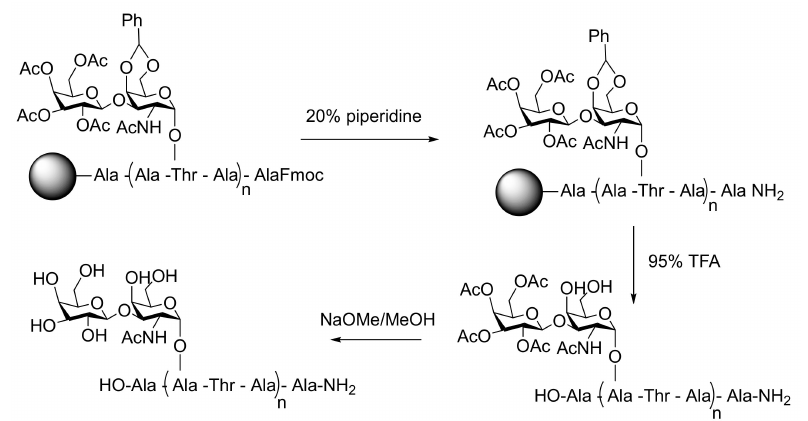
Figure 8. Solid-phase peptide synthesis of natural AFGPs. Acetyl groups protect the hydroxyl groups from the carbohydrate moiety attached to Thr used in the synthesis of the peptides. After the synthesis is finished, the glycopeptide is cleaved from the resin using strong acidic conditions. Finally, the protecting groups from the sugar are removed using sodium methoxide to obtain a chemically made